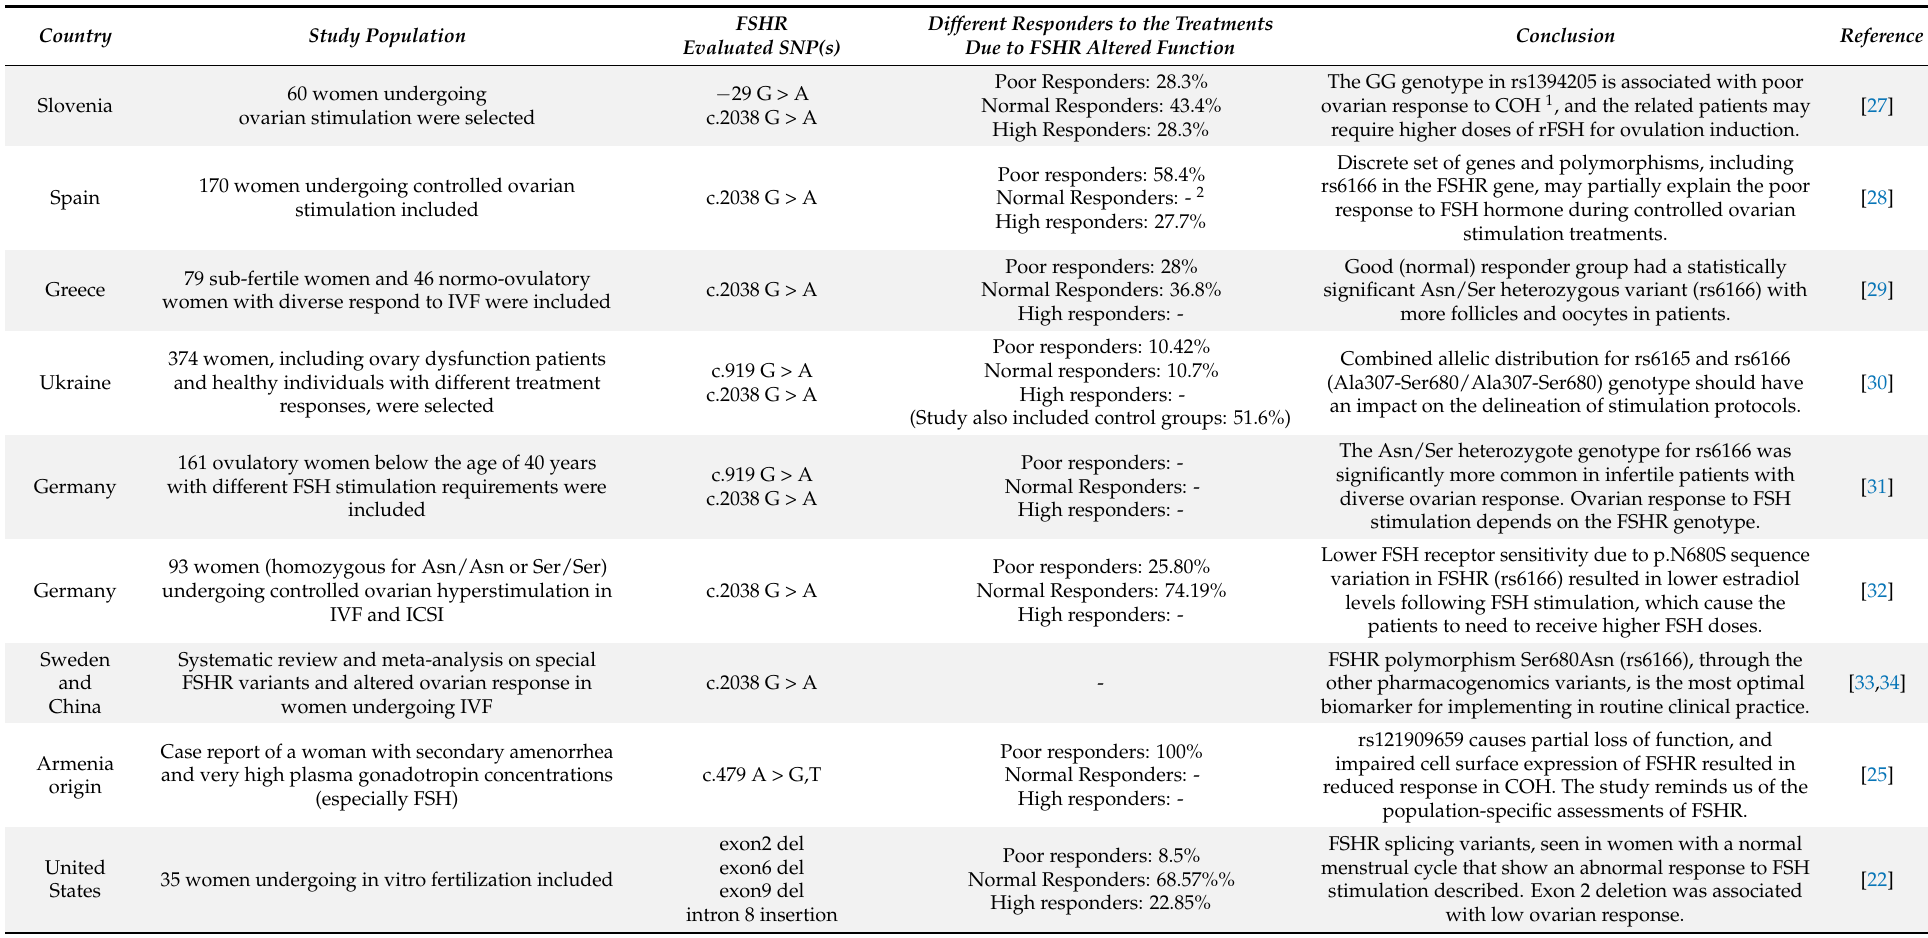
Table 2. Examples of diverse responses in different populations to assisted reproductive technologies (ART) treatments due to alterations in patients’ FSHR genetic make-up.